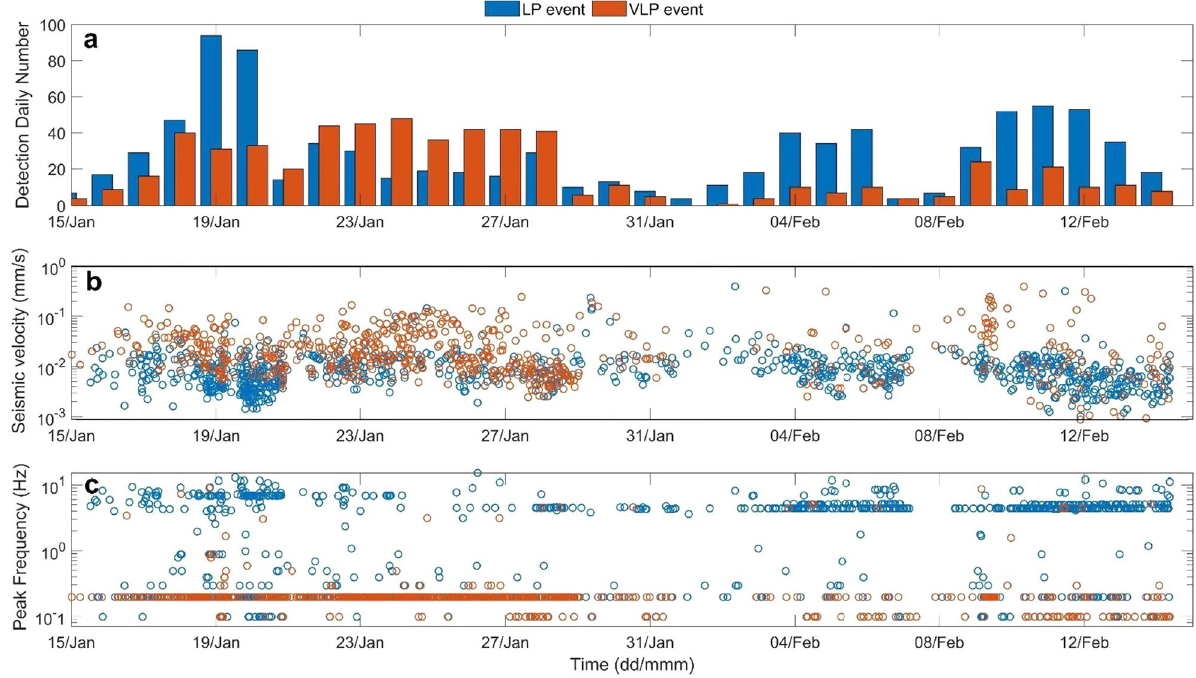
Figure 5. Daily number ( a ), peak-to-peak amplitude ( b ) and frequency peak ( c ) of LP (light blue) and VLP (orange) detected events of the INGV catalog in the time interval 15 January- 14 February